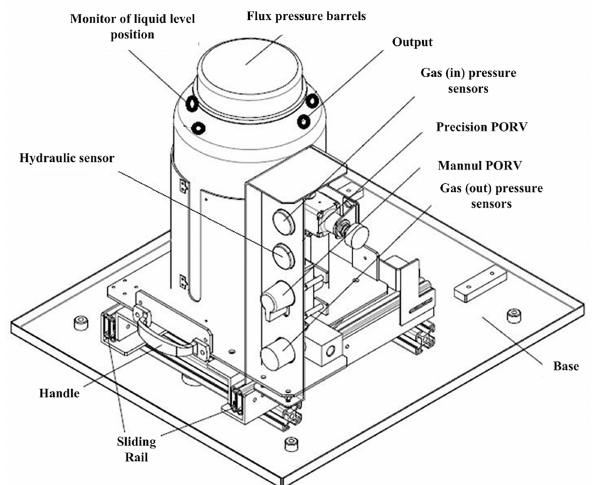
belt system, cutting mechanism system, welding platform systems, photovoltaic welding sys- tems, film system, lateral transfer system, flip mechanism and so on. In total, there are 309 fea- tures collected as shown in Table 1.